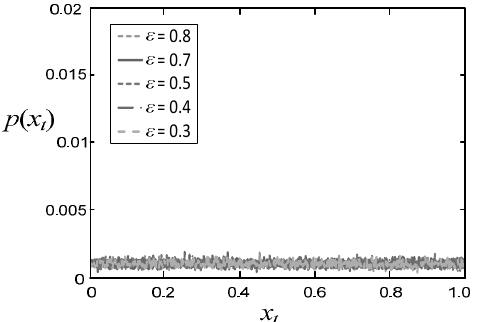
Figure 14. The structure of the improved compound seven stage CML, combining logistic map and tent map in alternate stage.